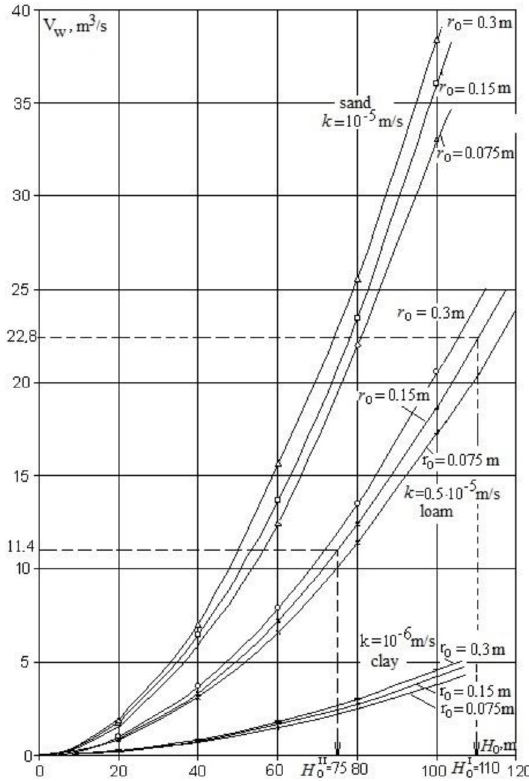
Fig. 2. Flow rate and depth of